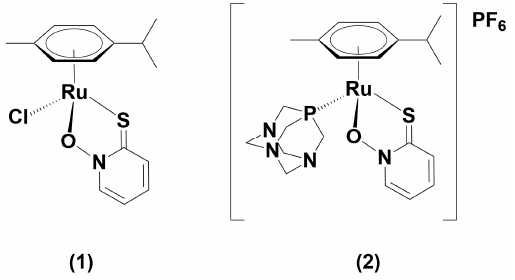
Figure 1. Chemical structures of [( η 6 - p -cymene)Ru(1-hydroxypyridine-2(1 H )-thionato)Cl] ( 1 ) and [( η 6 - p -cymene)Ru(1-hydroxypyridine-2(1 H )-thionato)pta]PF 6 ( 2 ).